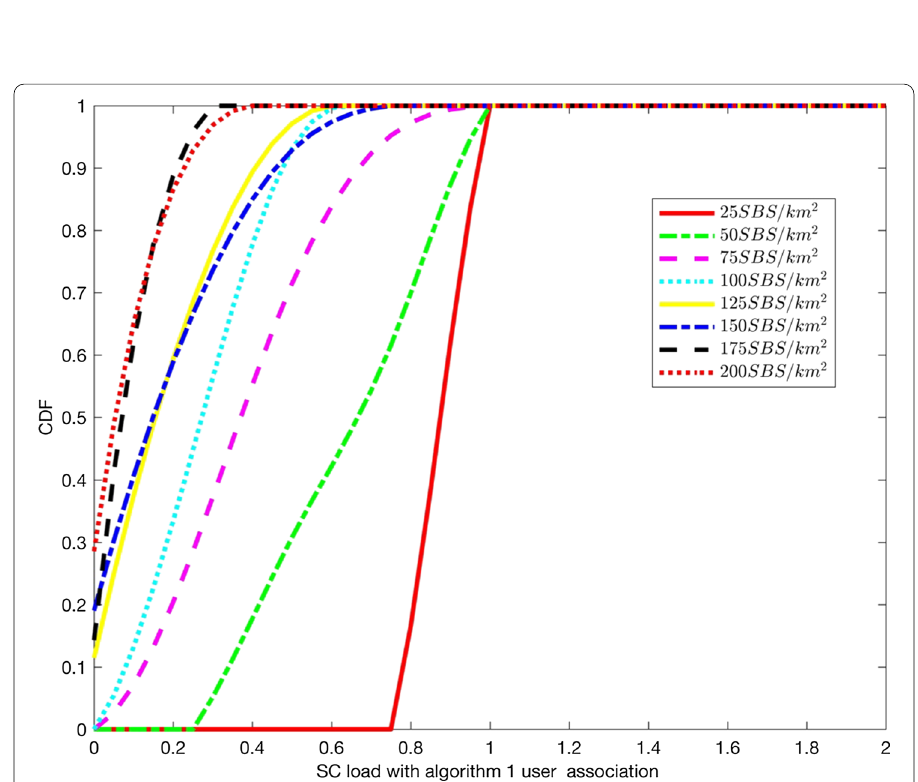
Fig. 7 SC load of algorithm 1 user association versus the different density of